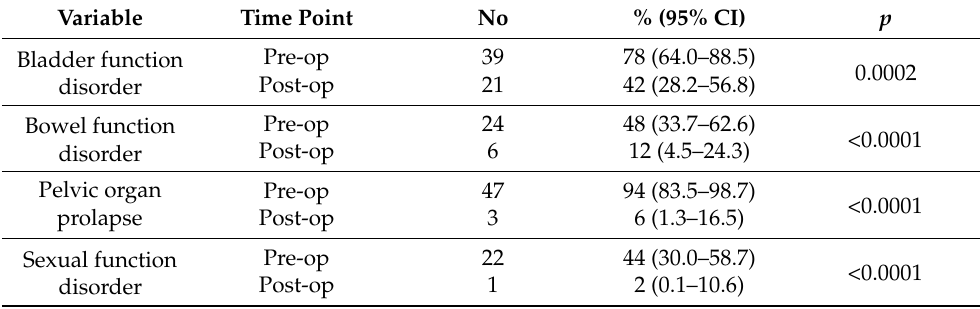
Table 2. Subjective outcome according to GPFQ.